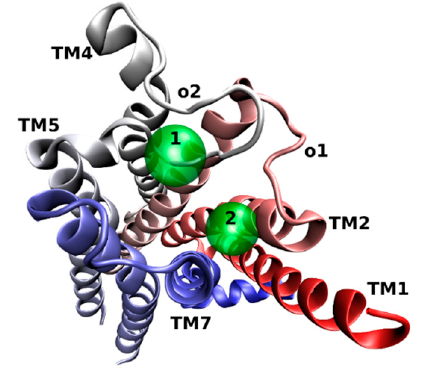
Figure 3. Extracellular view of two binding centers (green) in the common allosteric binding site at the M 2 receptor (4MQT) (colored in red-white-blue gradient).